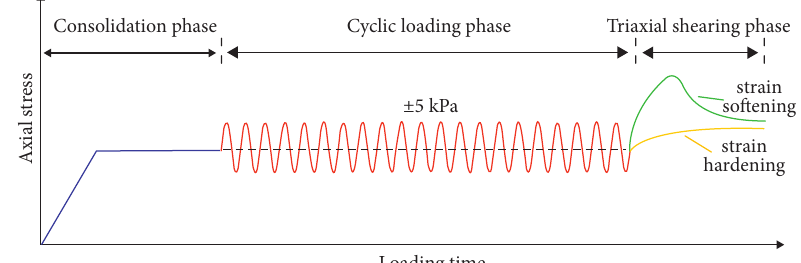
Figure 6: Loading diagram for triaxial tests on residual soil specimens with